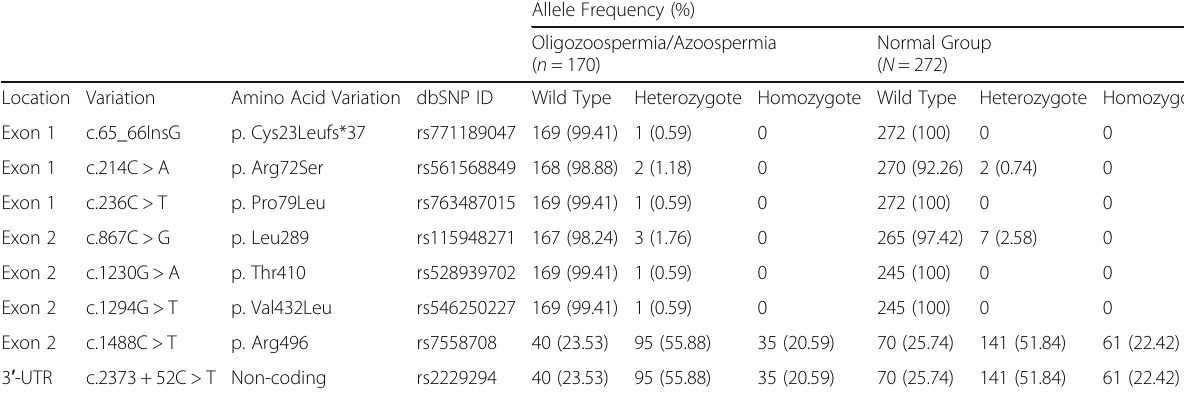
Table 2 EGR4 sequencing results from the non-obstructive azoospermia group